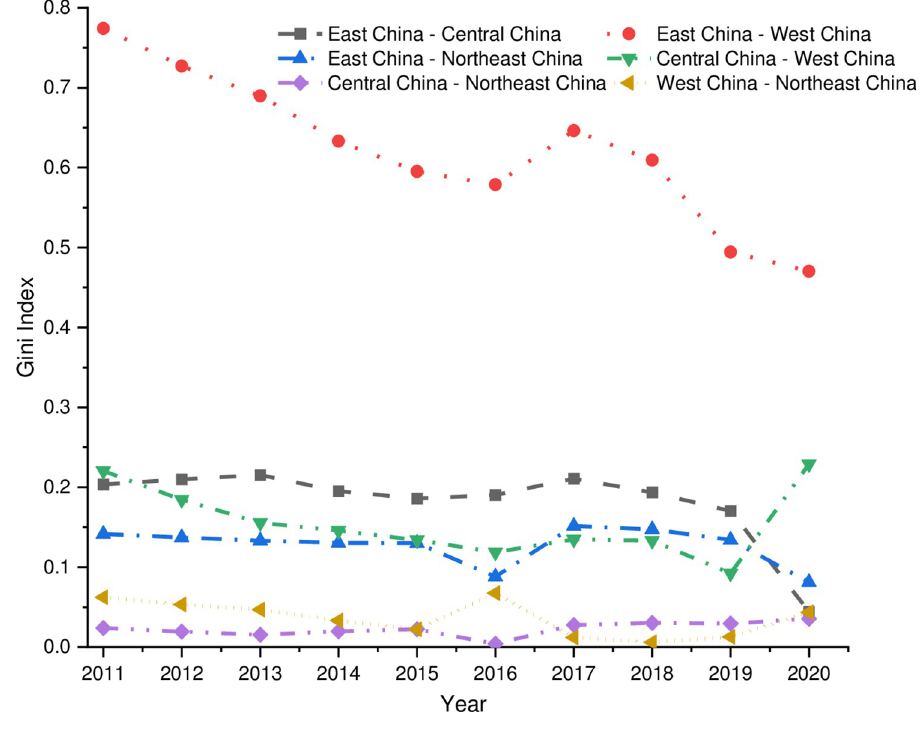
Fig 7. Inter-regional Gini